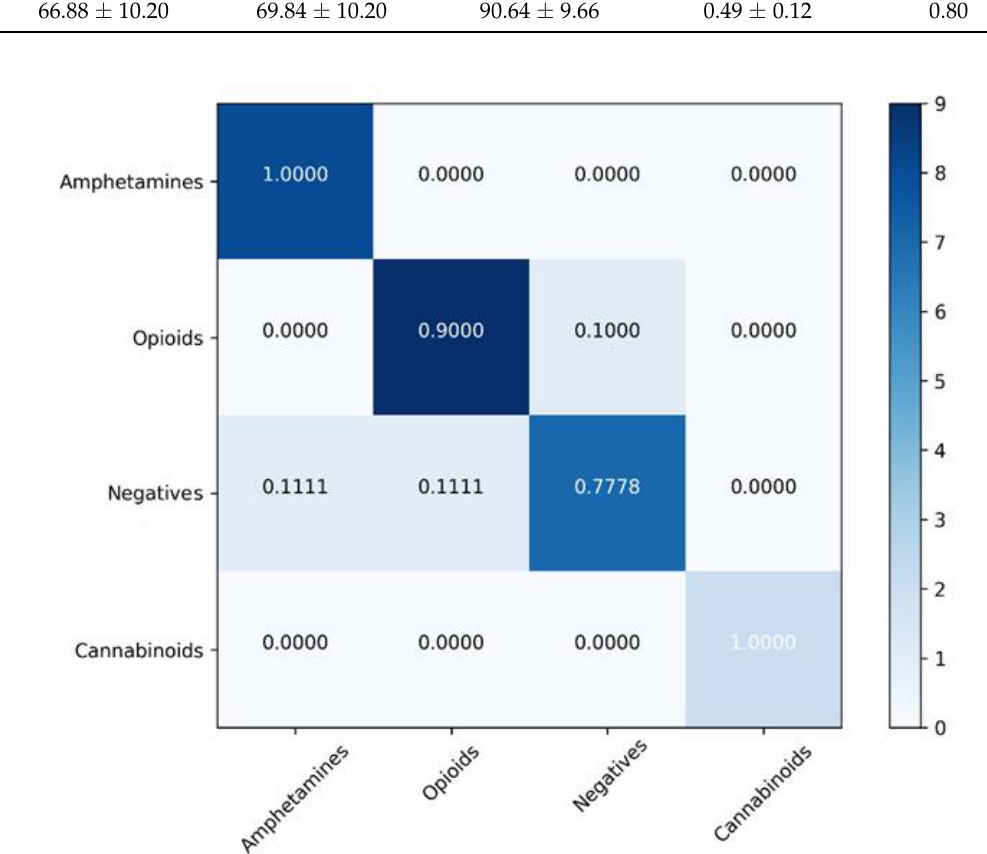
Figure 5. Confusion matrix for the SVM model.